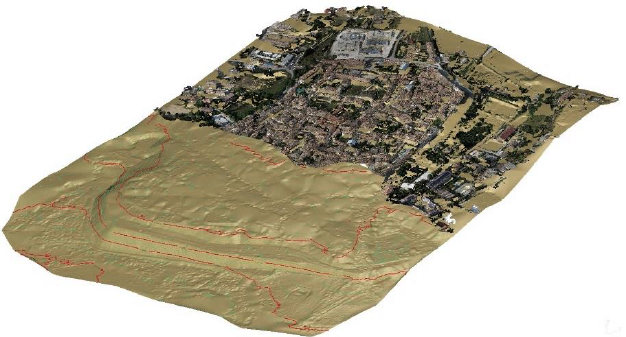
Figure 5. Segmentation of the DSM point cloud and interpolation of the DTM surface, with visualization of extracted isolines.